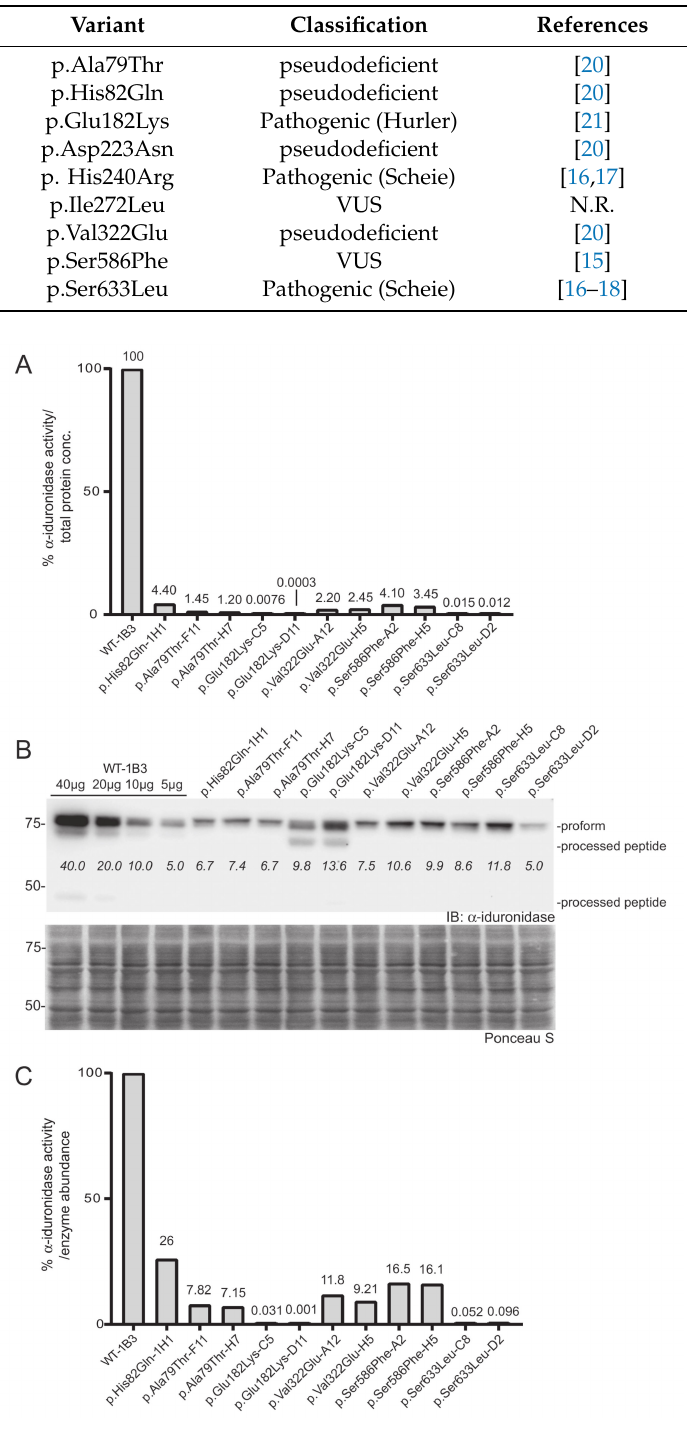
Figure 3. Determination of the relative specific activity in WT and variant IDUA - expressing cell clones. ( A ) Relative α -iduronidase activity in cell lysates from di ff erent single cell clones. ( B ) Representative Western blot for α -iduronidase in the cell lysates from these clones. Ponceau S staining was used to confirm equivalent total protein loading. ( C ) Relative specific activity determination in the clones calculated by dividing relative enzyme activity by relative α -iduronidase abundance as measured by